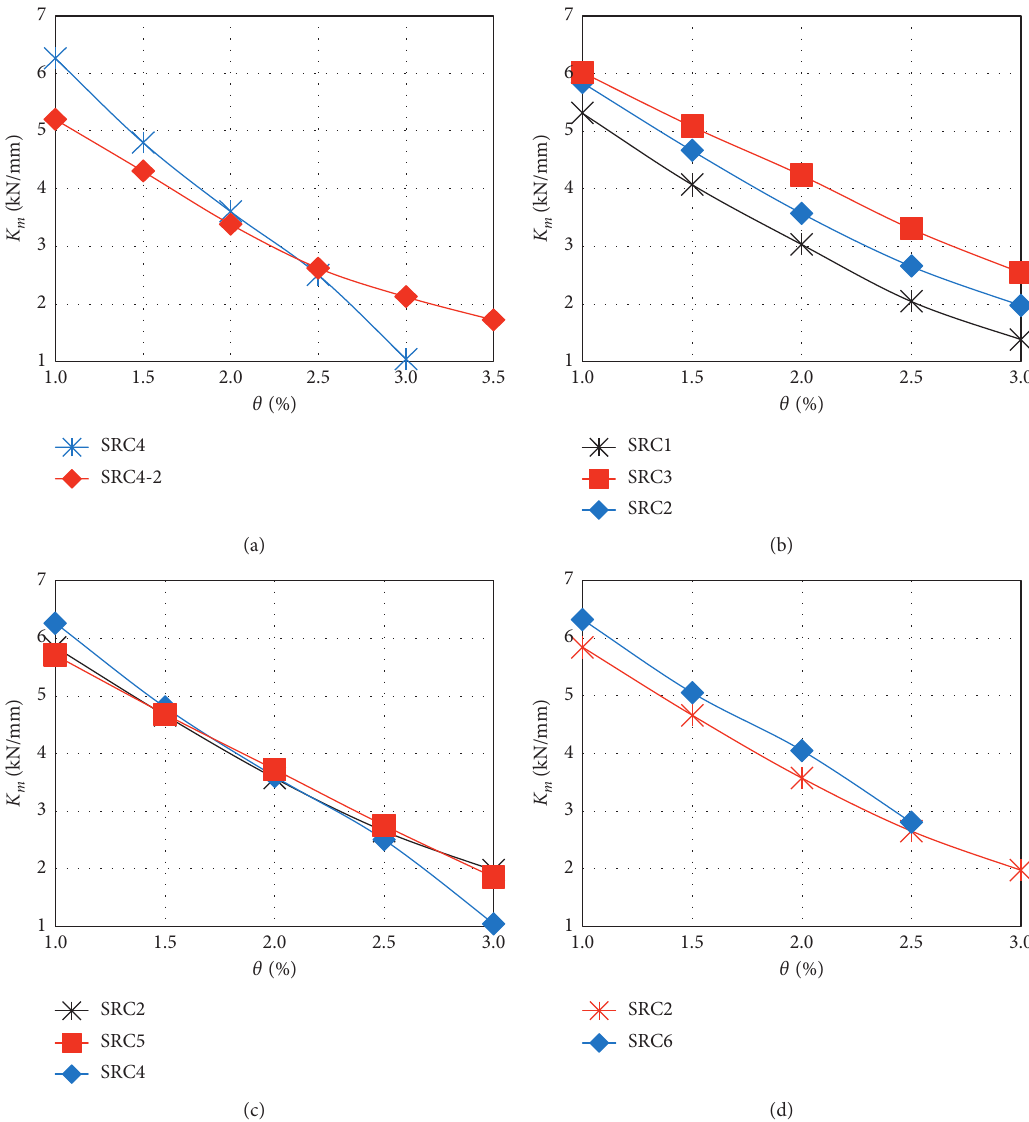
Figure 5: Relation curves of average secant stiffness-displacement angle ( K (b) steel ratio on K m , (c) stirrup ratio on K m , and (d) axial compression ratio on K m